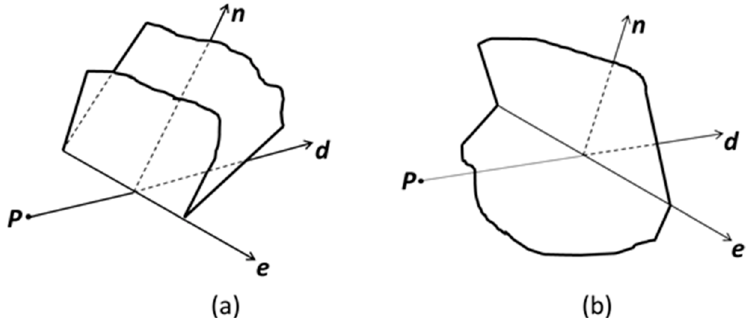
Figure 7. Illustration for two configurations for when the test ray P + t d intersects a shared edge e at an interior edge point, where n represents the normal direction of e × d . ( a ) The faces are on the same side of the plane formed by the edge and the ray, while parity is not changed. ( b ) The faces are on opposite sides, thus parity is toggled.